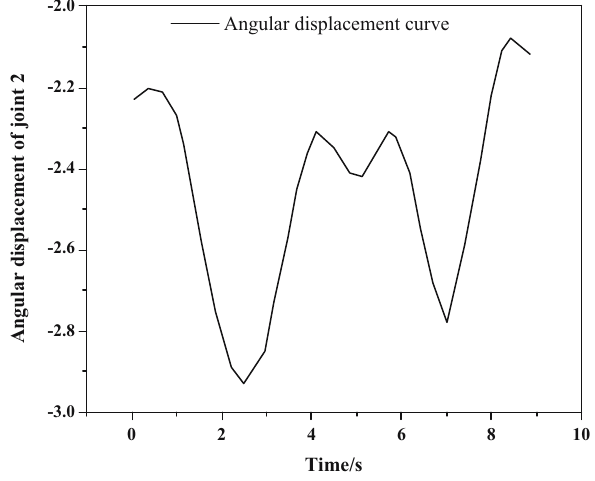
Figure 4: Angular displacement curve of joint 2 of cubic B - spline